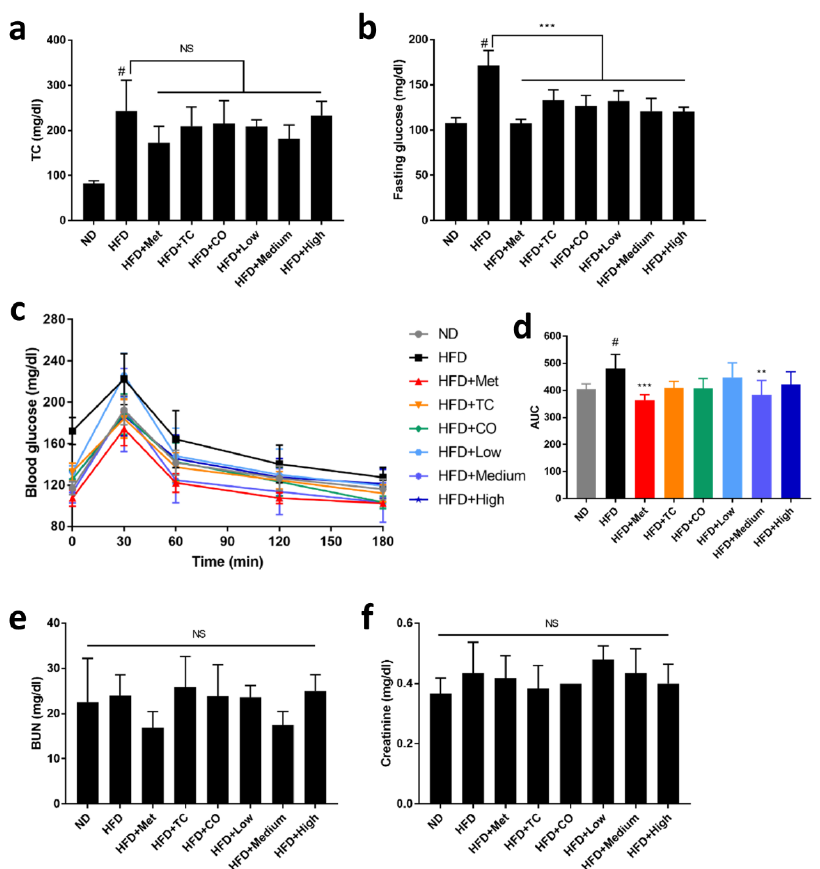
Figure 3. Effects of CO/TC formula on serum biochemical index (n = 6). ( a ) Total cholesterol. ( b ) Fasting glucose. ( c ) Oral glucose tolerance test and ( d ) its area under the curve (AUC). ( e ) Level of blood urea nitrogen. ( f ) Level of creatinine. Data are reported as mean±SD and analyzed by one-way ANOVA with Tukey post-hoc test. # p < 0.05 was considered significant for ND vs. HFD. *** p < 0.001, ** p < 0.01 vs. HFD group. NS, represents no significance difference ( p > 0.05).